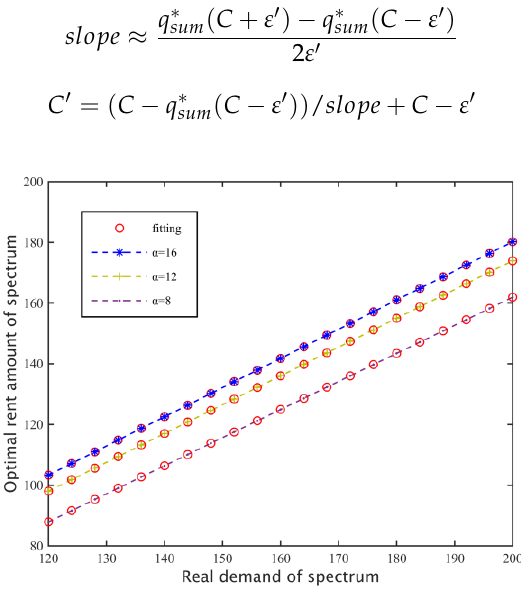
Figure 3. The relationship between spectrum demand and optimal rent number. In summary, when the primary base station is based on the local information of dynamic spectrum pricing, the scheduling process of first stage is as shown in Figure